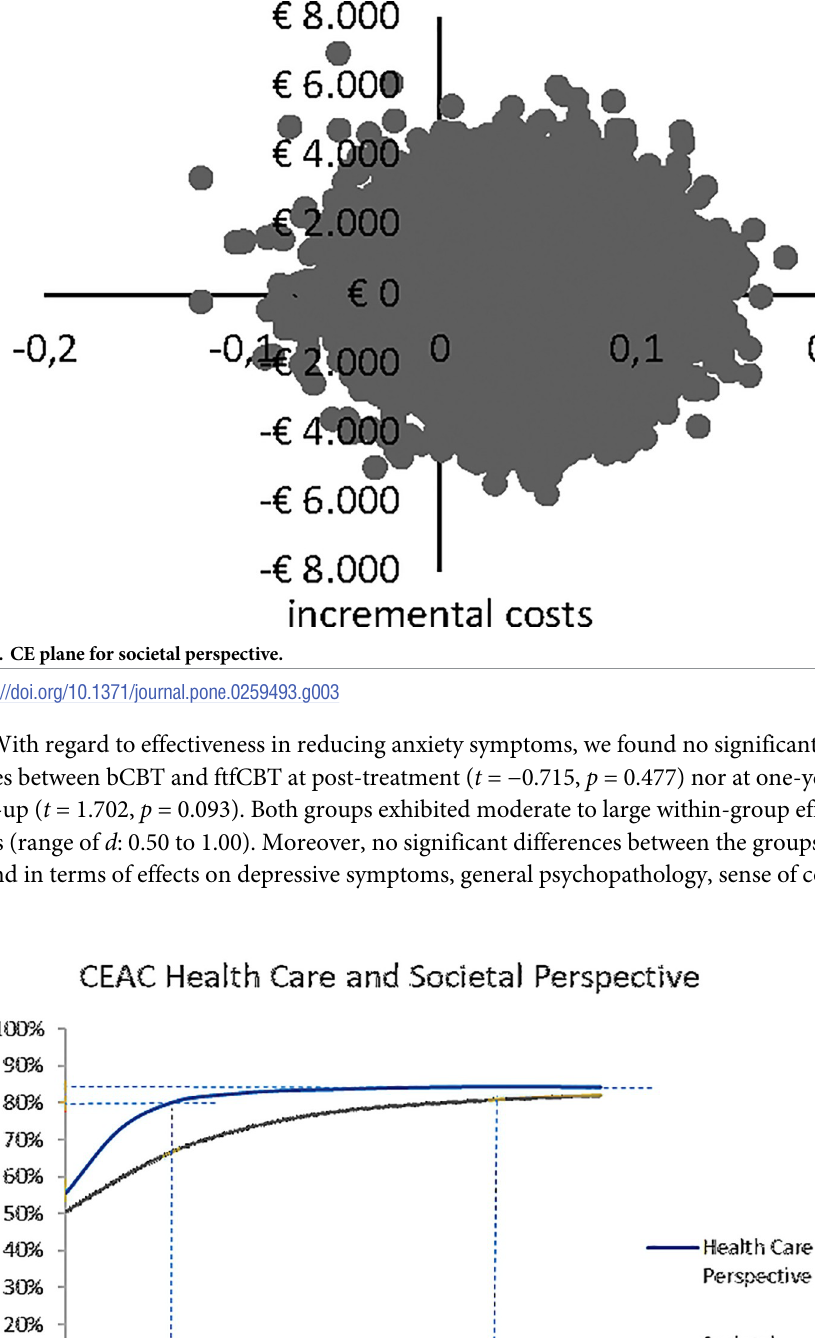
Fig 4. Cost acceptability curves from the societal perspective and health care